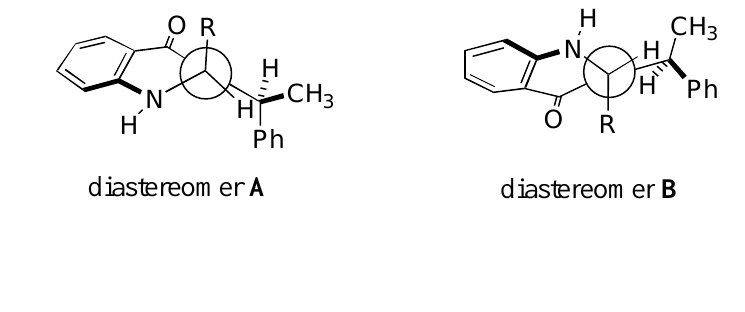
Figure 1. The conformation of 1-phenethyl group, is the key point to assign the absolute configuration of new stereogenic carbon C2 of diastereomers A and B by routine 1 H- NMR